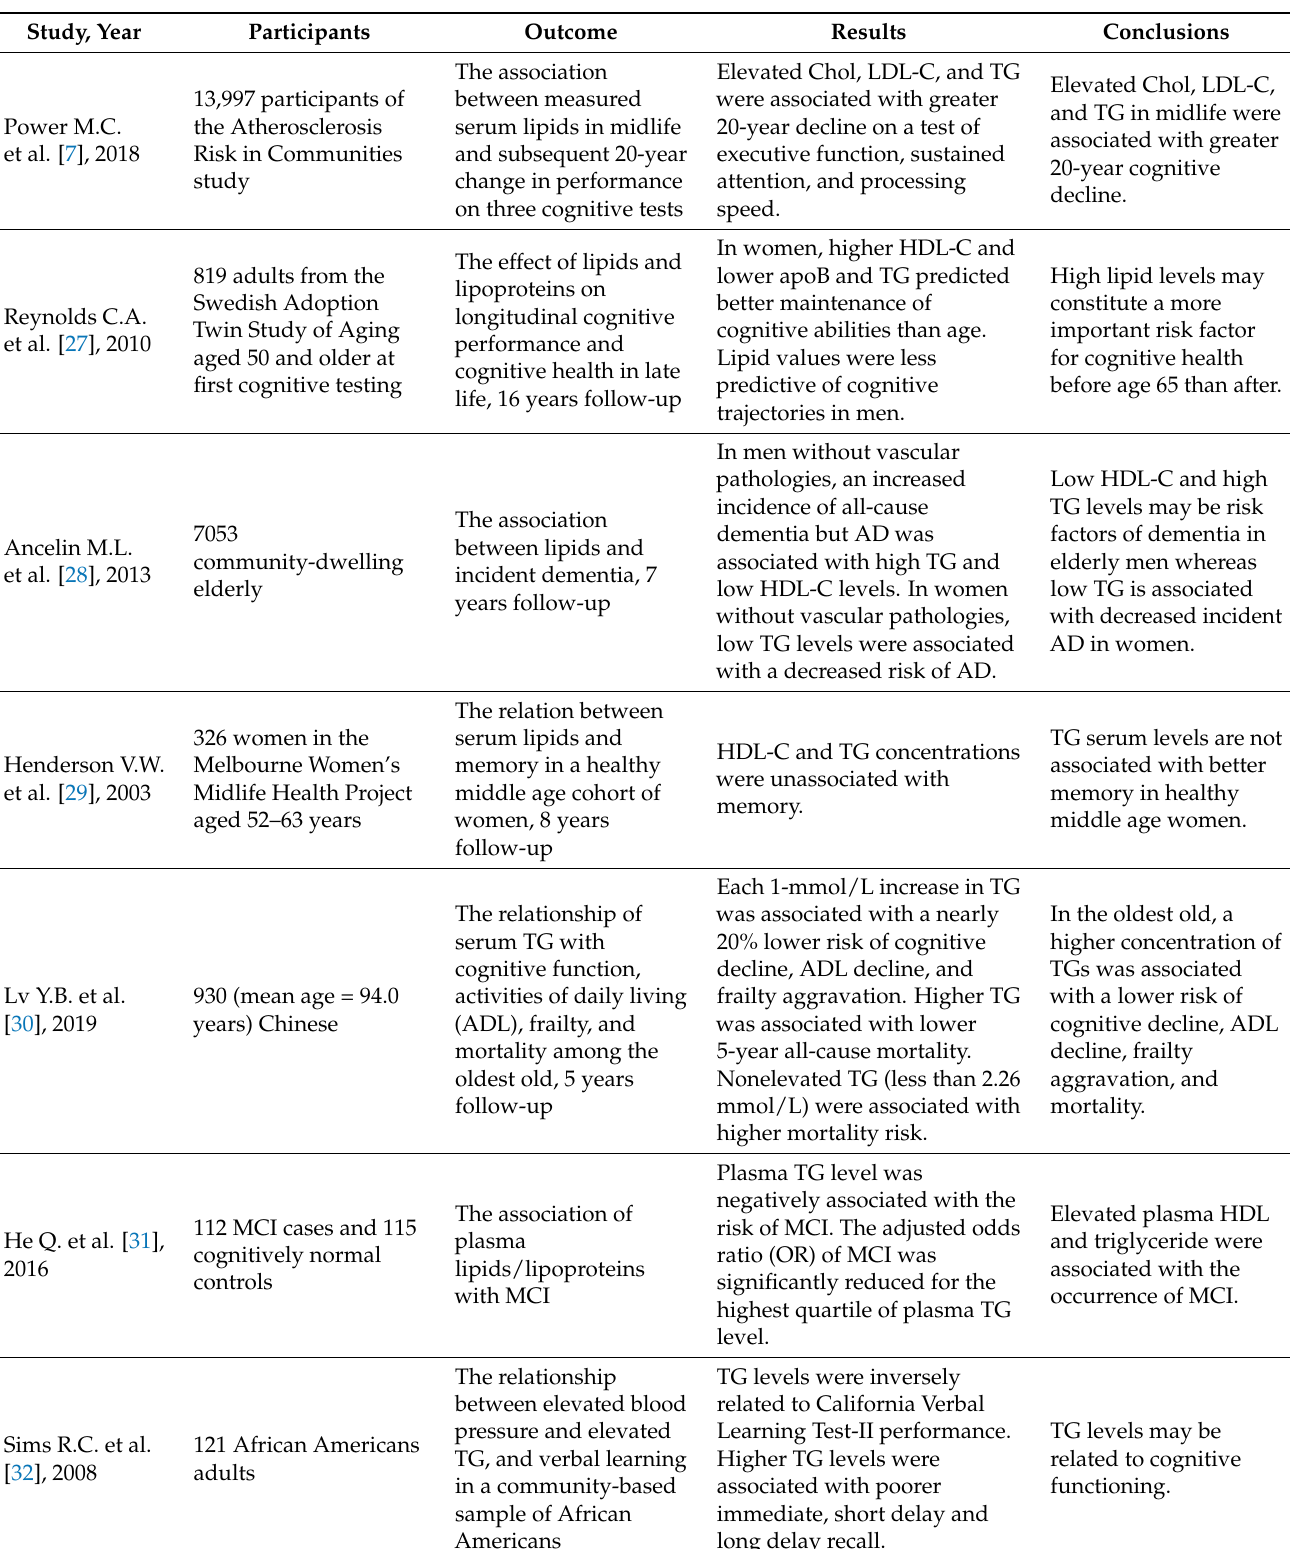
Table 1. Characteristics of the clinical studies concerning serum triglycerides and cognitive